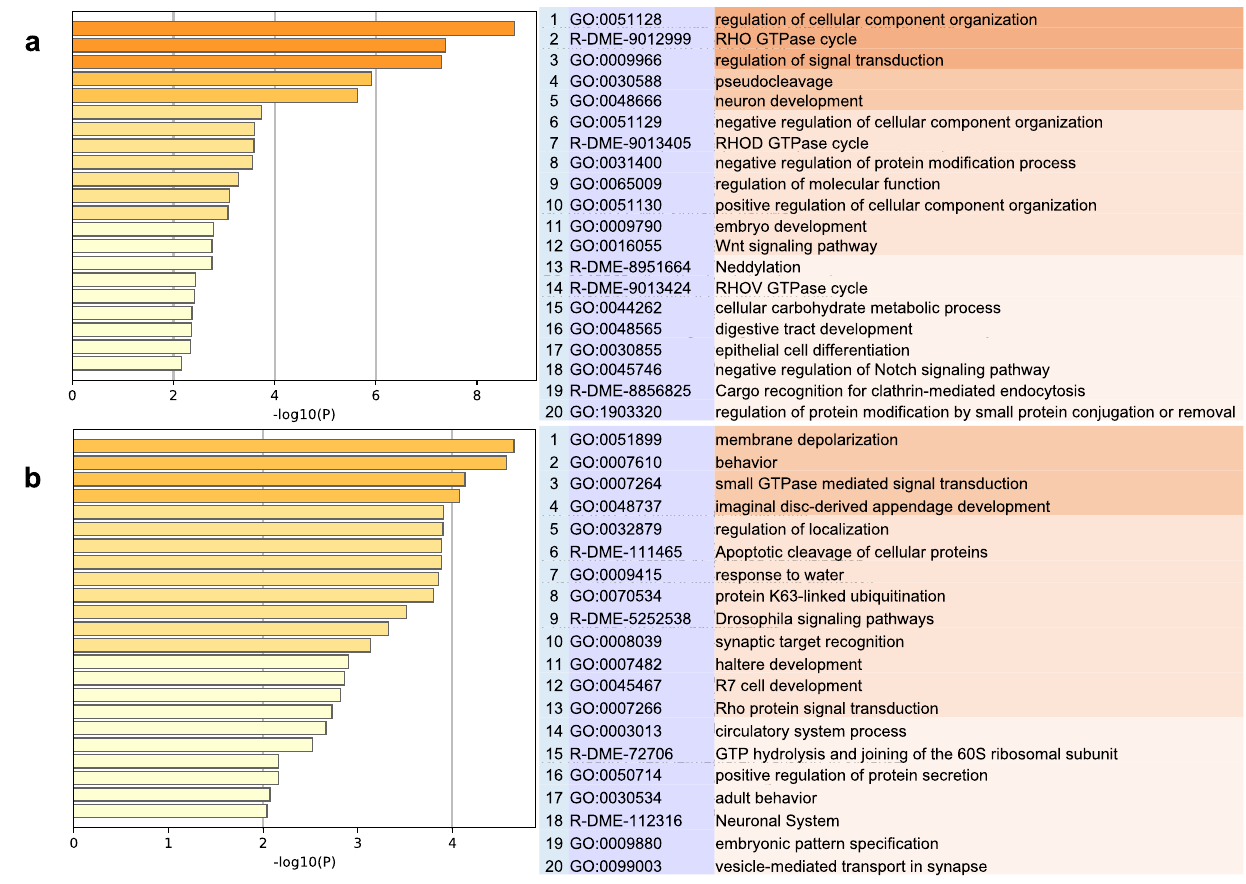
Figure 6. The gene transcript levels in the TcSOD6 -knockdown groups were compared with those in the TcVer -knockdown groups by RNA-seq analysis. Transcripts with different expression levels between the TcSOD6 dsRNA-injected group and the controls were used for gene enrichment analysis. A heatmap of enriched terms across the input transcript lists; differently coloured bars indicate P values. ( a ) Upregulated genes in the TcSOD6 dsRNA-injected group ( b ). Downregulated genes in the TcSOD6 dsRNA-injected